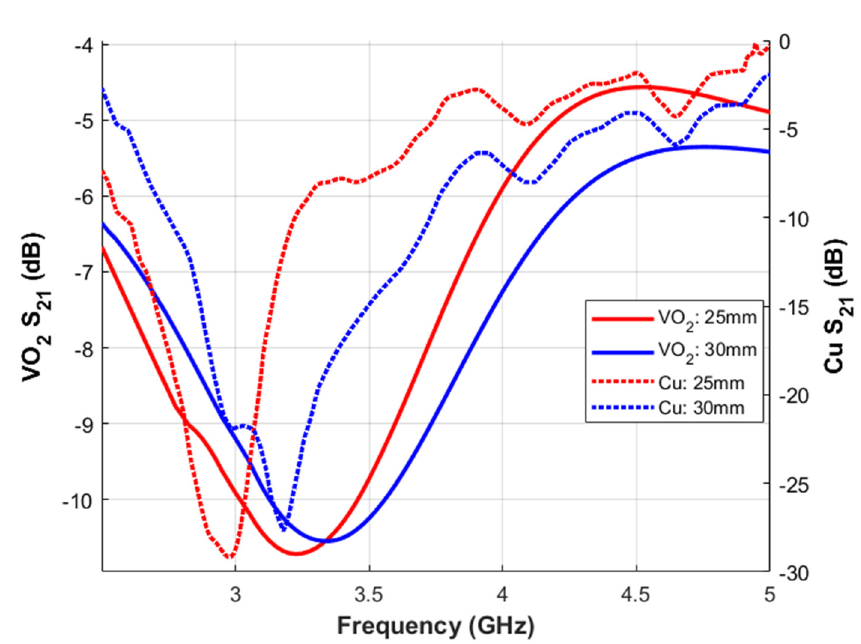
Figure 12. The graph of the measured transmission coefficient of VO 2 and Cu double dipoles for separations of 25 mm and 30 mm.